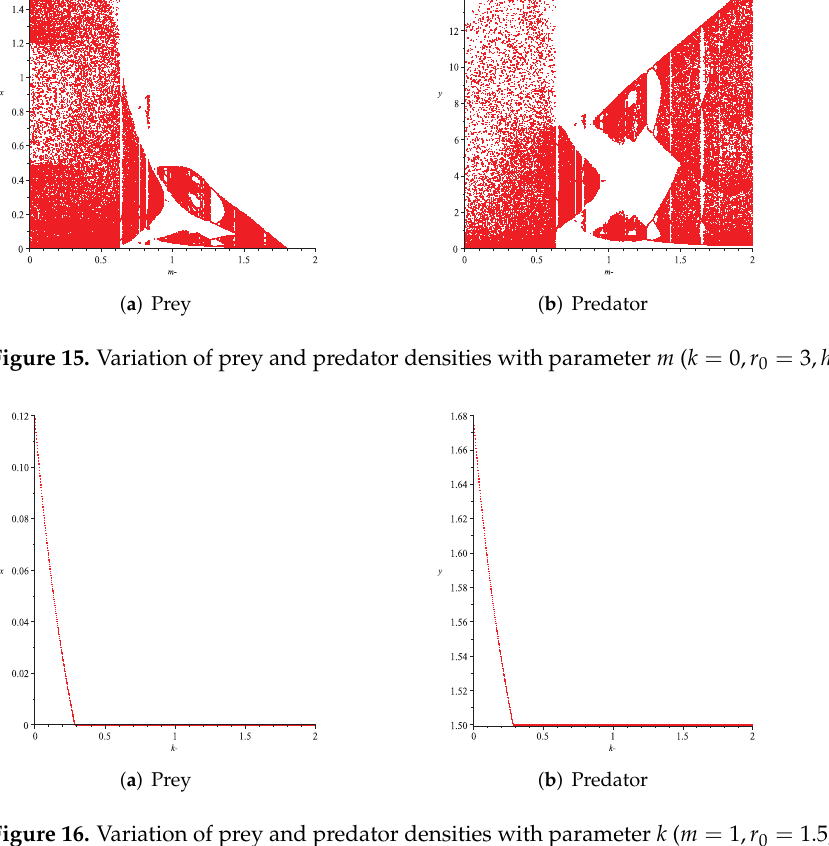
Figure 16. Variation of prey and predator densities with parameter k ( m = 1, r 0 = 1.5, h = 1.5).